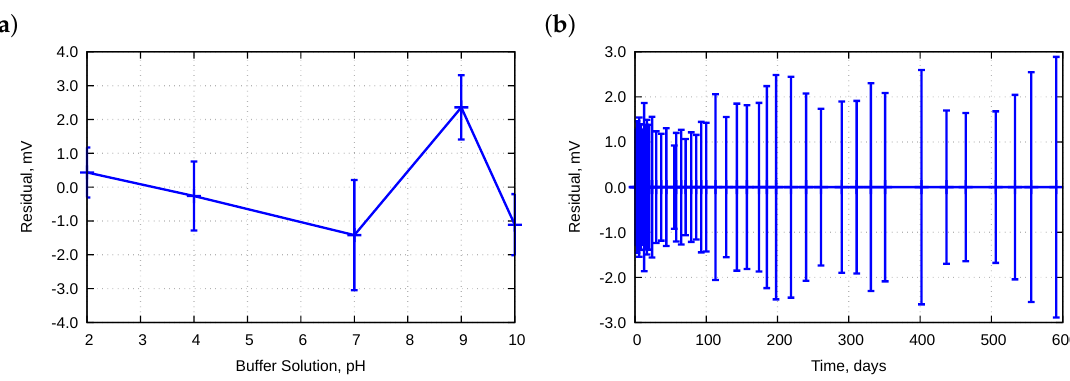
Figure 7. Averaged residuals obtained during approximation to the Nernst equation for electrodes E01–E11 as a function of: ( a ) pH; and ( b ) lifetime. Bars mean standard